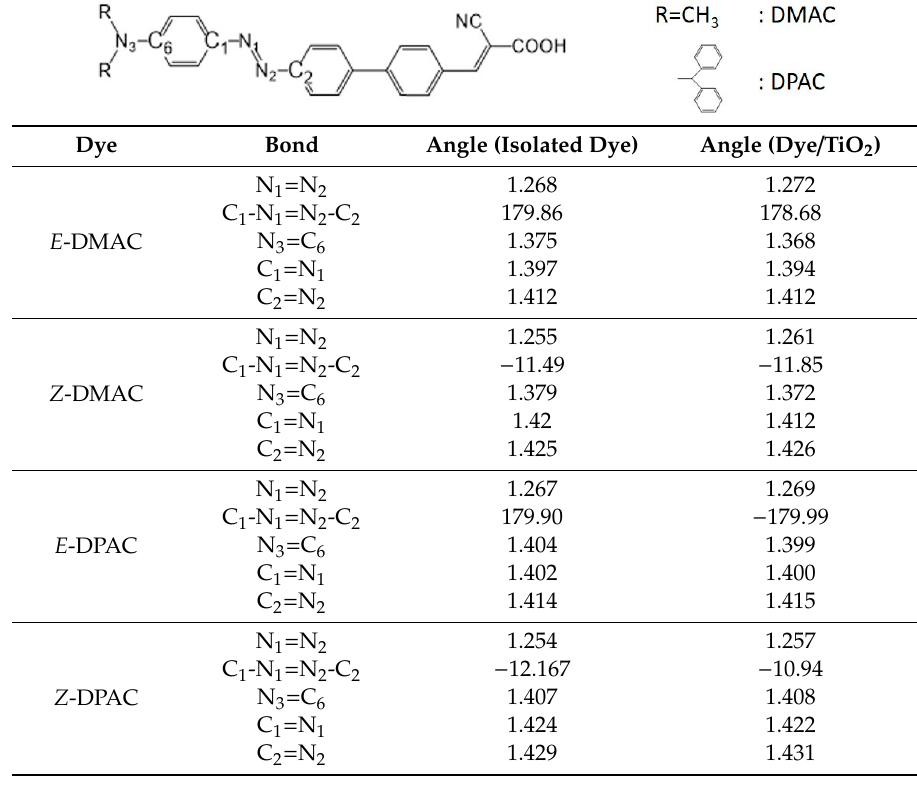
Table 1. Structural parameters of DMAC and DPAC as isolated dyes and dye / TiO 2 complexes. A schematic representation of the dye is shown below.